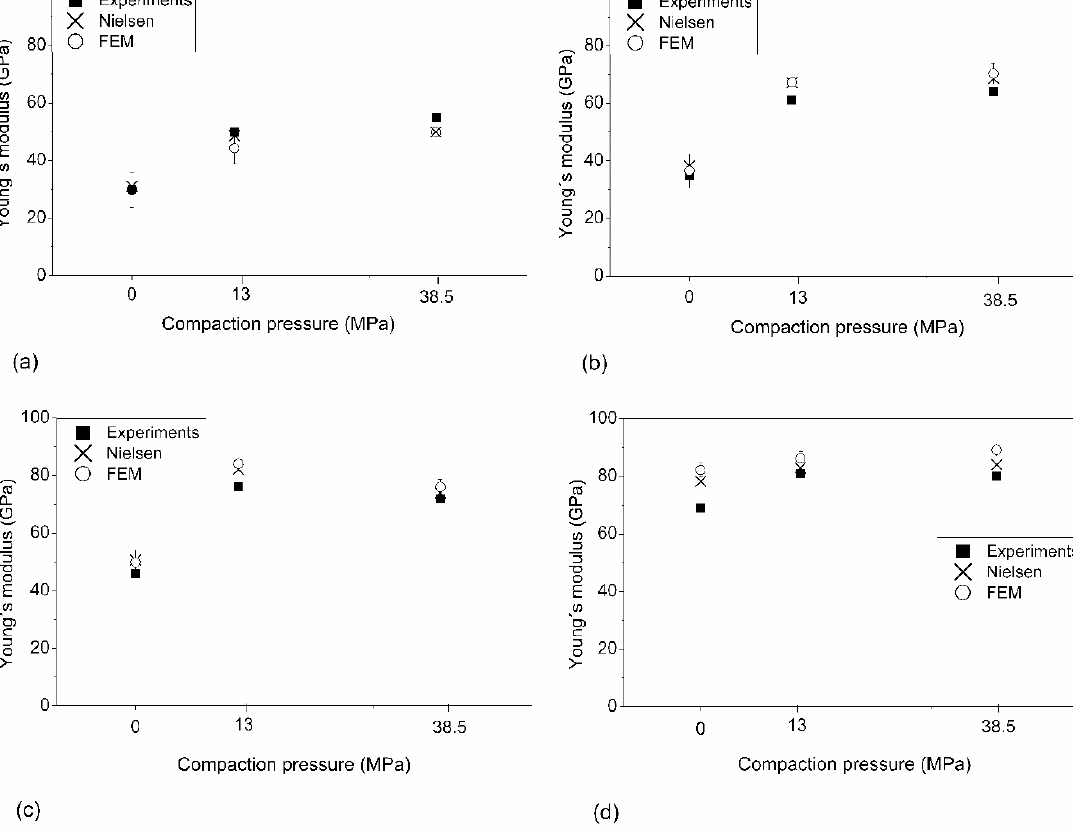
Figure 7. Experimental and simulated Young’s modulus in terms of compaction pressure, for each sintering temperature: ( a ) 1000 °C; ( b ) 1100 °C; ( c ) 1200 °C; and ( d ) 1300 °C.